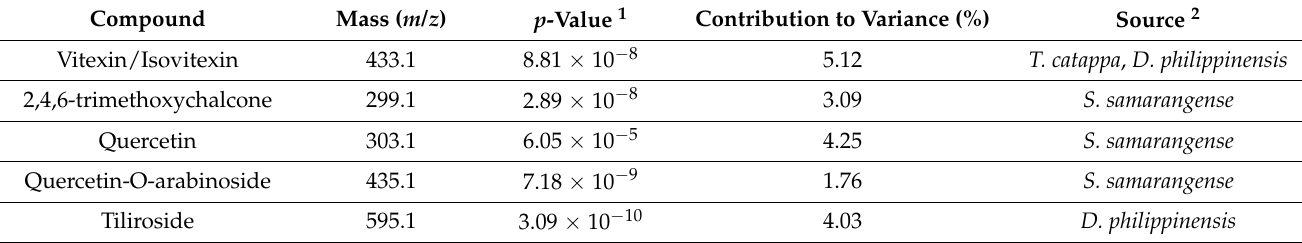
Table 1. Highly significant and variable chemical features determined by XCMS